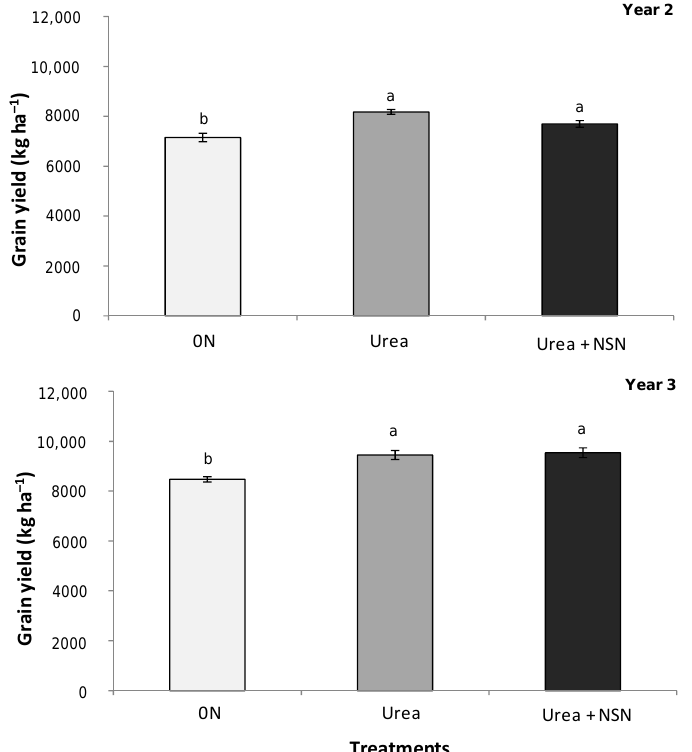
Figure 4. Grain yield affected by N rate and urea or urea treated with NSN (urea + NSN) applied broadcast on the surface to no-till corn during three growing seasons. Means followed by the same letter are not significantly different from each other based on the LSD test (0.05). Vertical bars indicate standard error. NSN, maleic itaconic acid.